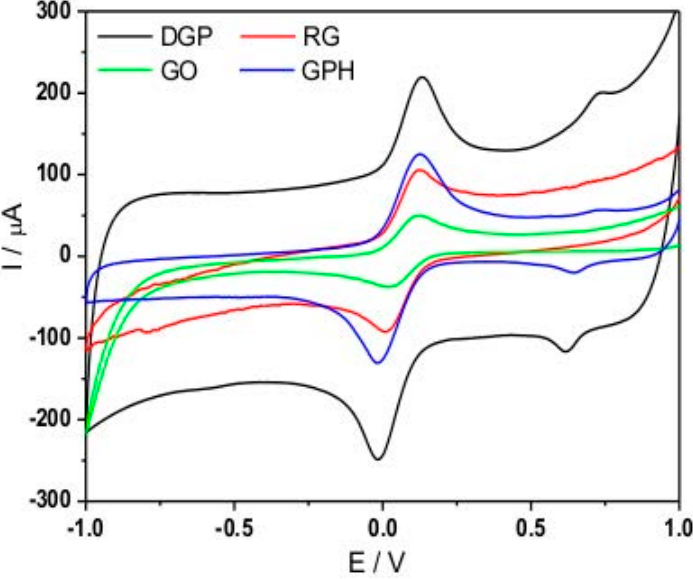
Figure 7. Cyclic voltammograms of graphite (GPH), dispersed graphene nanoplatelets (DGP), graphene oxide (GO), reduced graphene oxide (RGO).